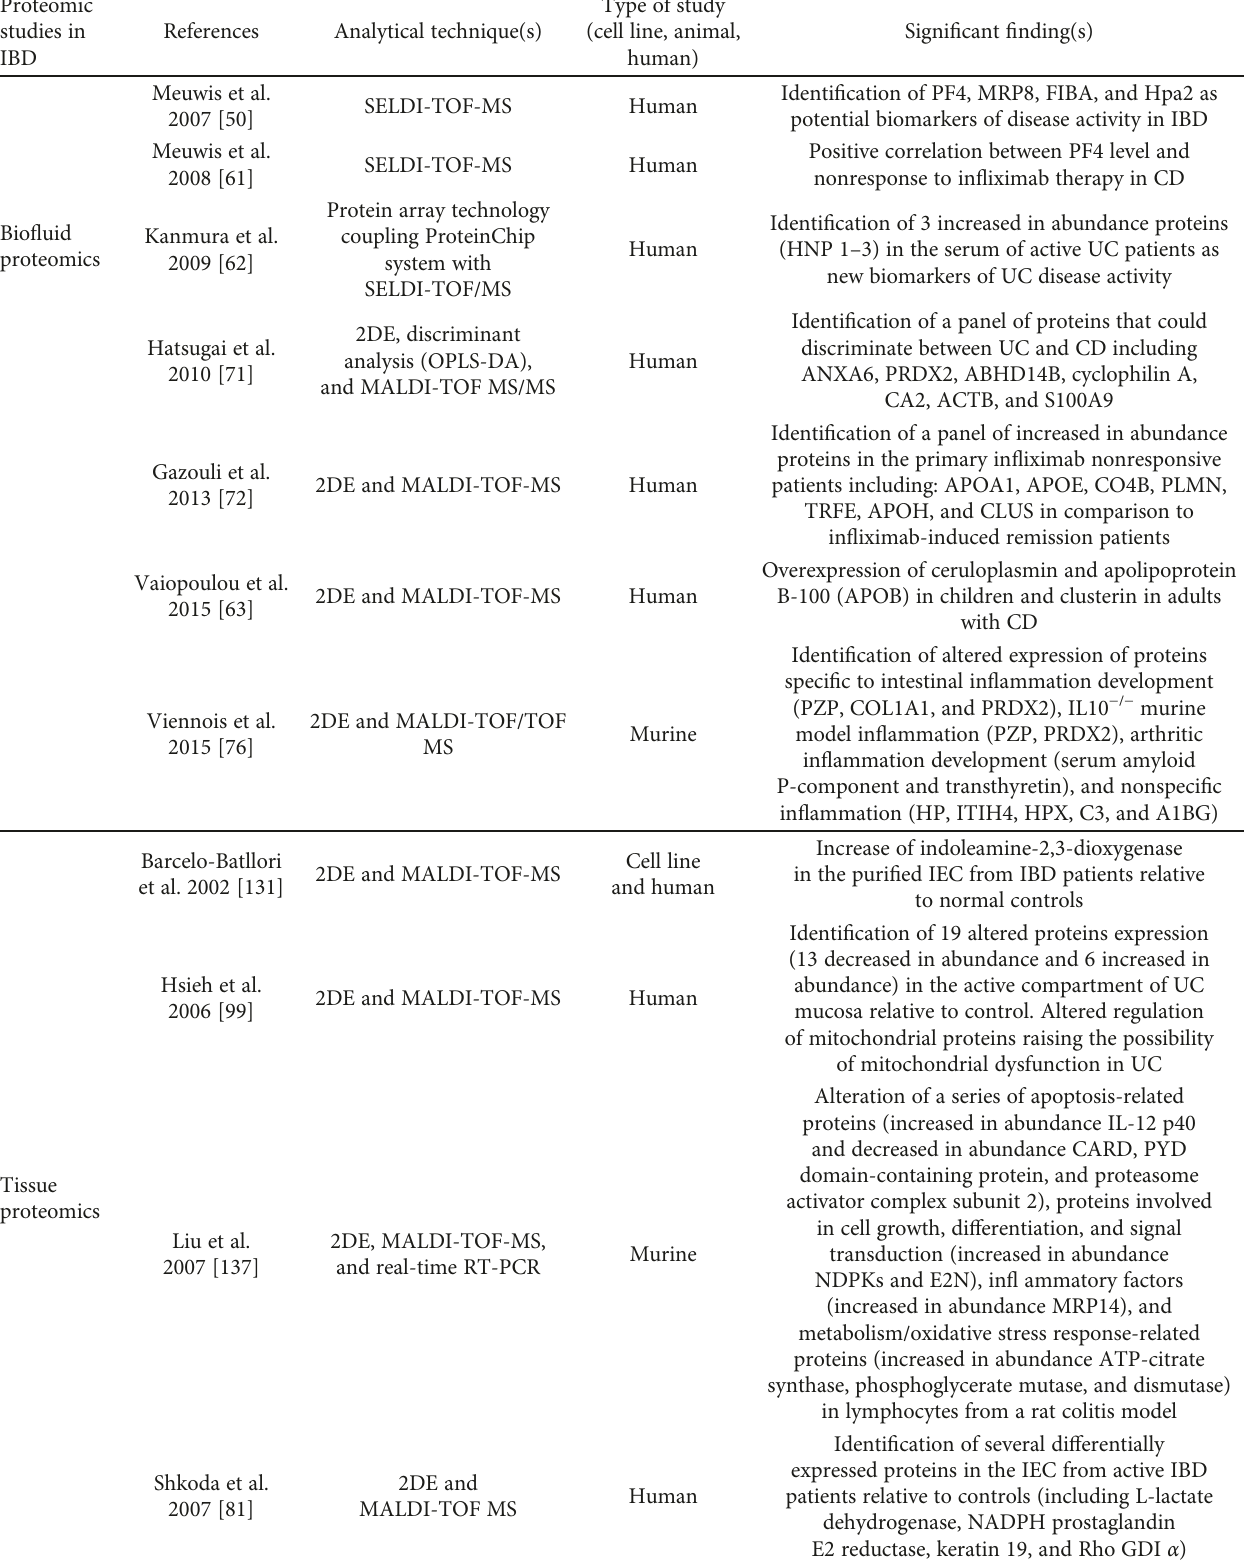
Table 2: High-throughput proteomic studies in